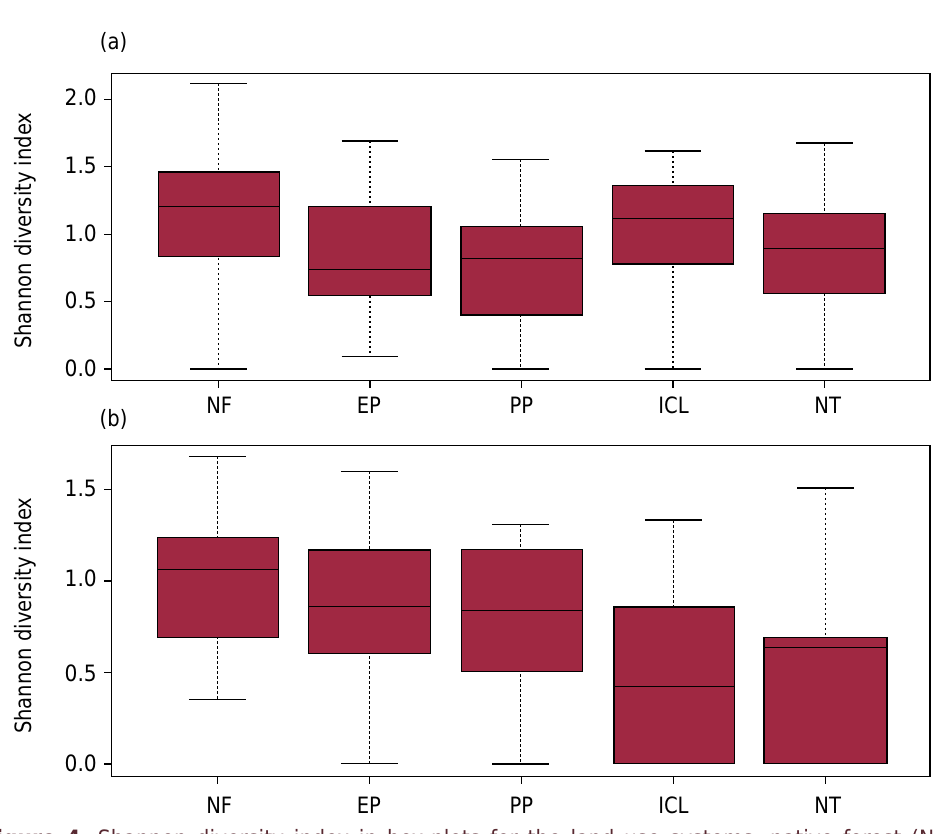
Figure 4. Shannon diversity index in box-plots for the land use systems: native forest (NF), eucalyptus plantations (EP), perennial pasture (PP), integrated crop-livestock (ICL), and no-tillage (NT) in the summer (a) and winter (b), in the eastern region of Santa Catarina,